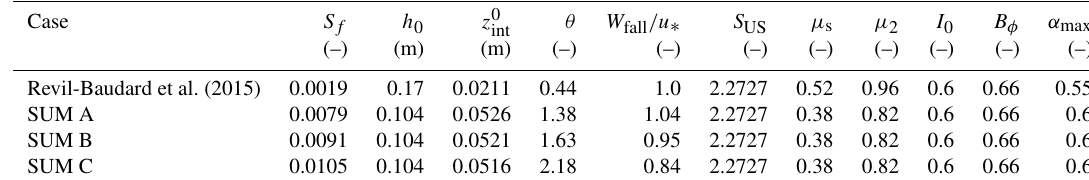
Table 9. Physical parameters for the numerical simulations of Sumer et al. (1996) experiments.